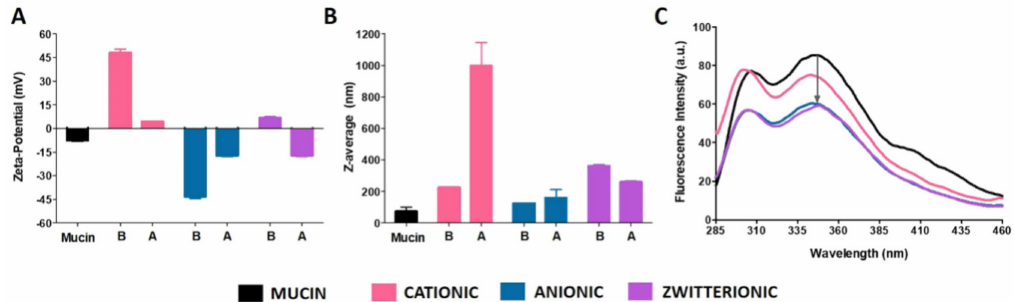
Figure 5. The e ff ect of the surface charge of liposomes in zeta potential ( A ) and hydrodynamic diameter or Z-average ( B ), before (indicated by the letter B in x -axis) and after (indicated by the letter A in x -axis) interaction with a mucin suspension. Fluorescence emission spectra of mucin before interaction with liposomes and after interaction with cationic, anionic, or zwitterionic liposomes are presented in ( C ) (spectra follow the same color code used in bars of panels ( A , B